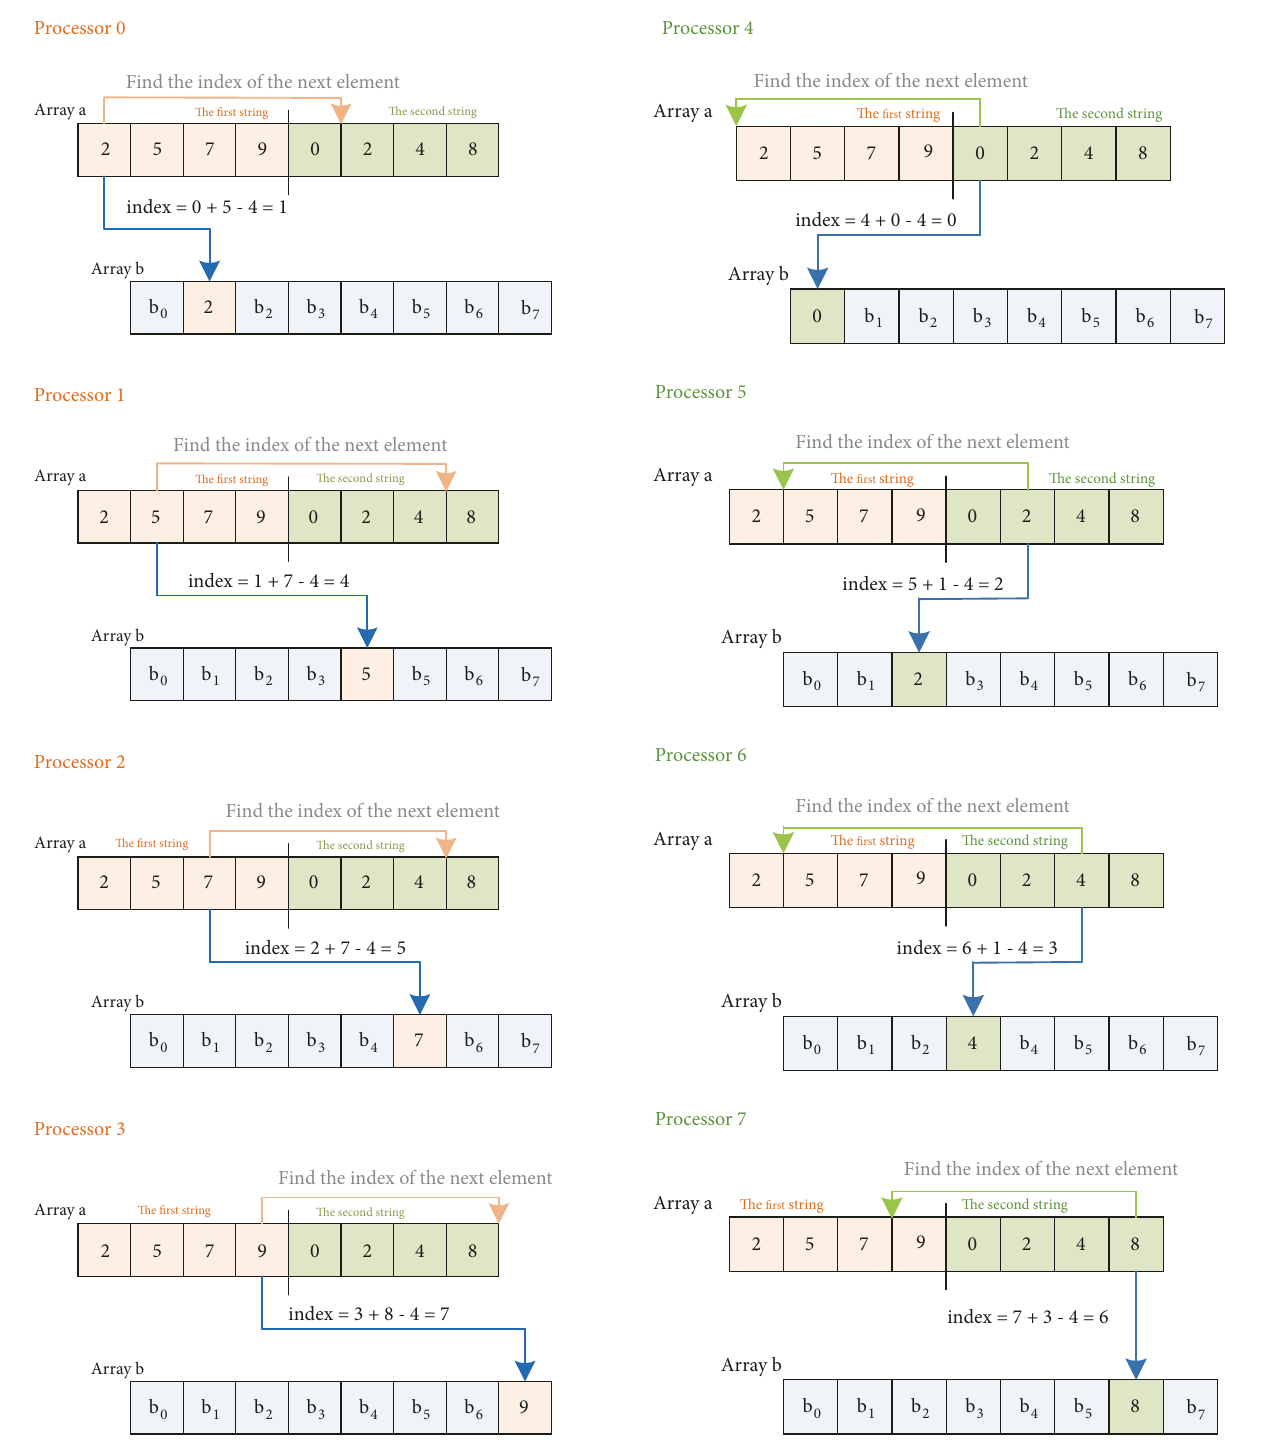
𝑃 𝑎 5 sorts element 5